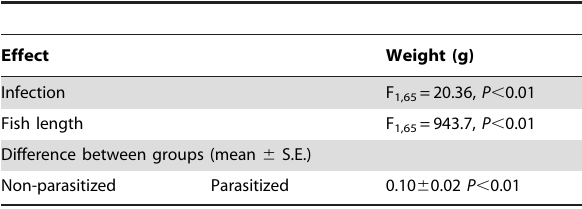
Table 1. Infection effects of Bothriocephalus acheilognathi on the weight of Cyprinus carpio captured from the wild.